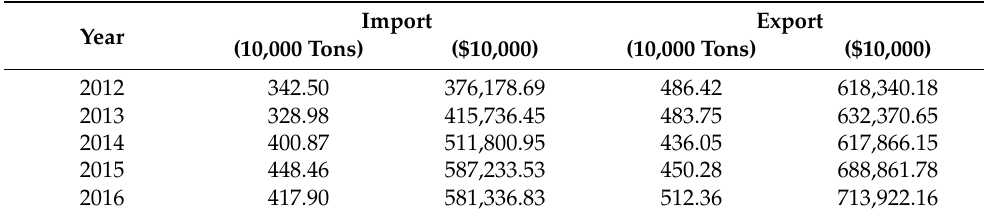
Table 2. The annual import and export volumes and data amounts in